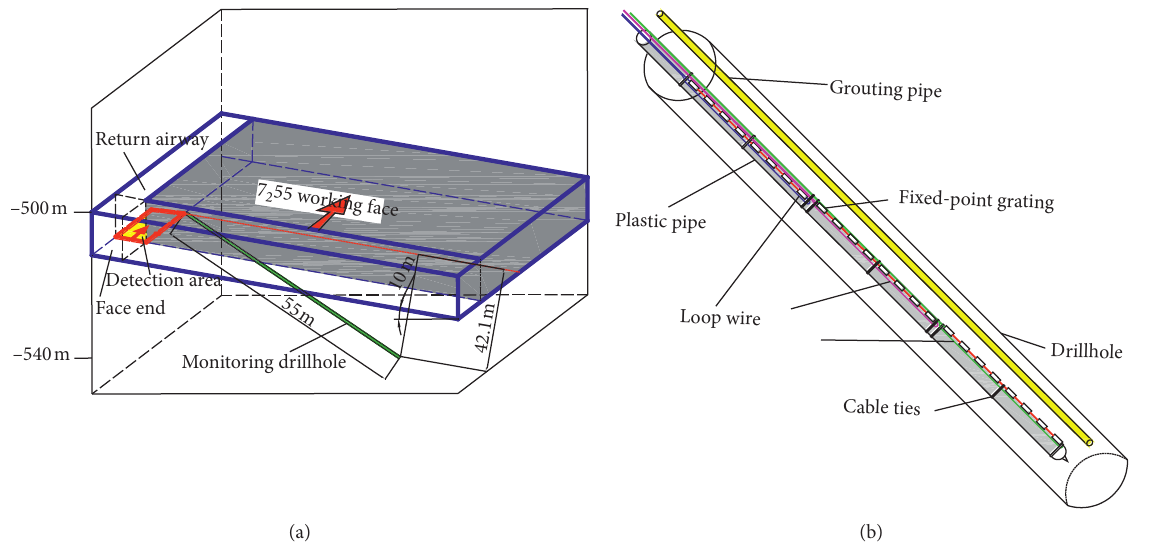
Figure 4: Drilling diagram showing (a) borehole location and (b) monitoring of borehole structure.